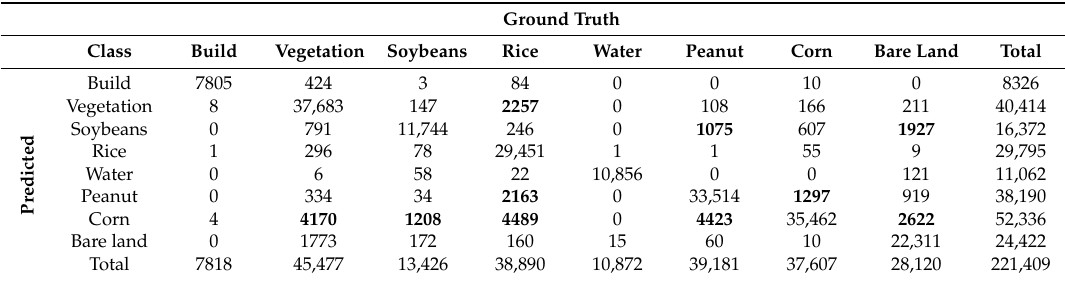
Table 8. Confusion matrix of the crop mapping result using